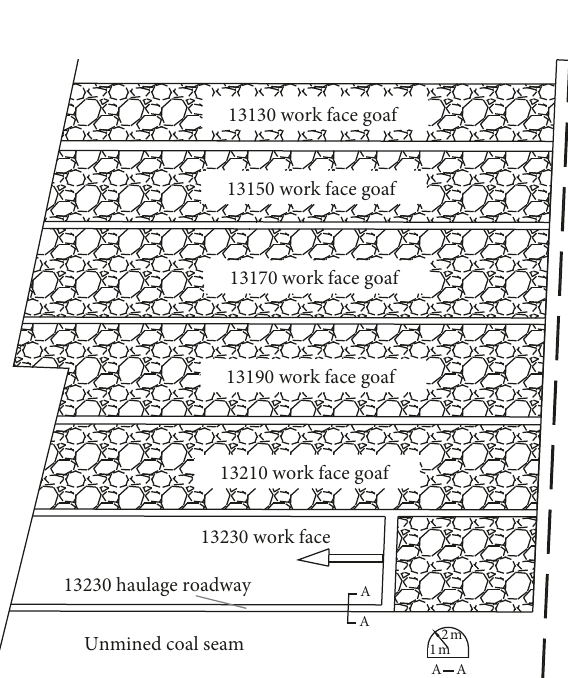
Figure 9: Work faces layout of mining area in Gengcun mine in